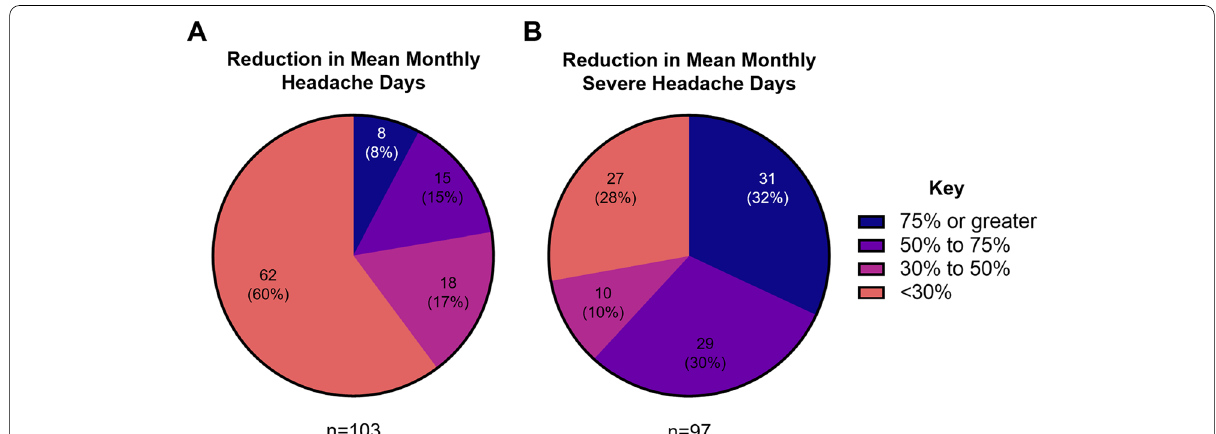
Fig. 3 pie charts showing reductions in mean headache days ( a ) and severe headache days ( b ) observed over the study period compared to